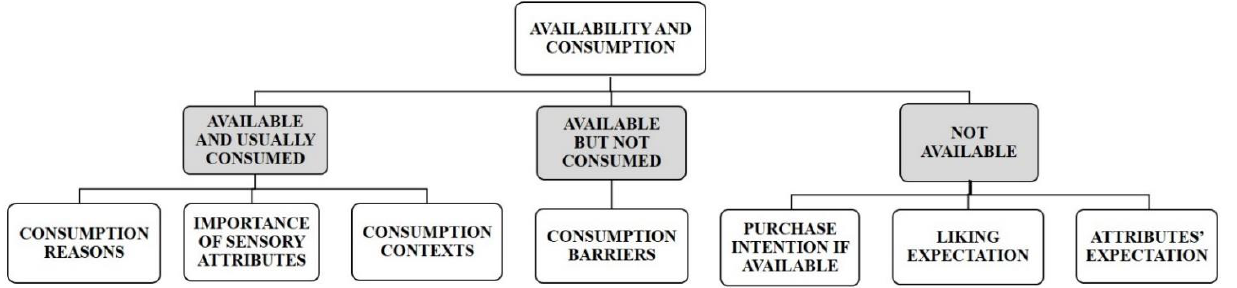
Figure 1. Scheme of the main questionnaire sections.